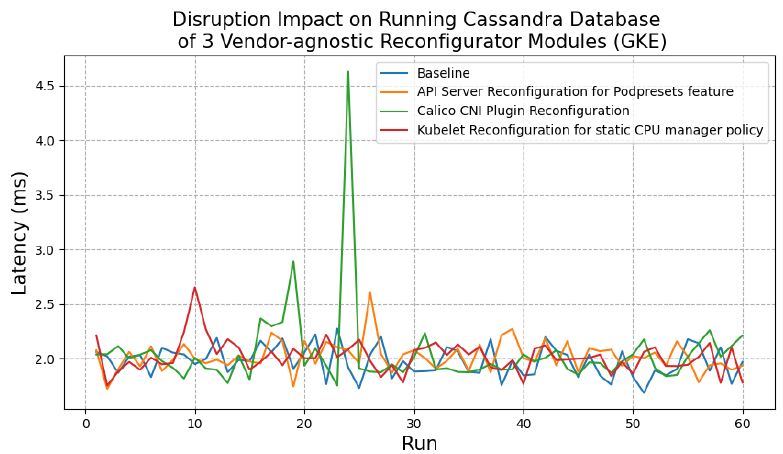
Figure 10. Disruption impact of three Reconfigurator modules on Cassandra database.